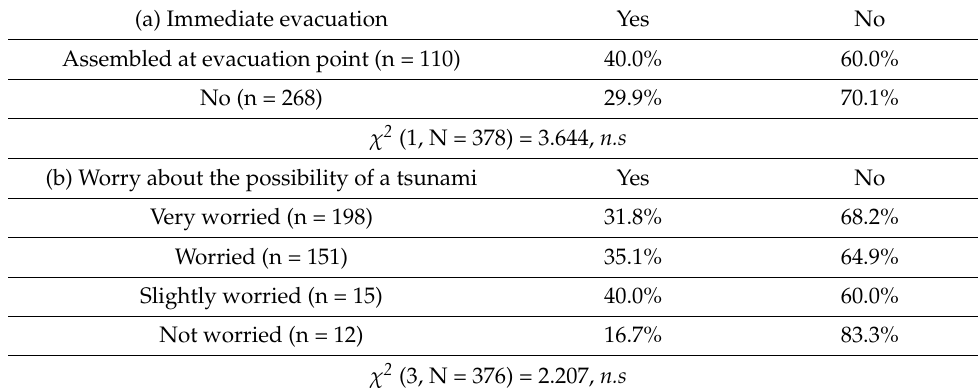
Table 13. Preparedness (disaster risk reduction (DRR) activity participation) and (a) immediate evacuation (N = 378) and (b) worry about the possibility of a tsunami (N = 376).